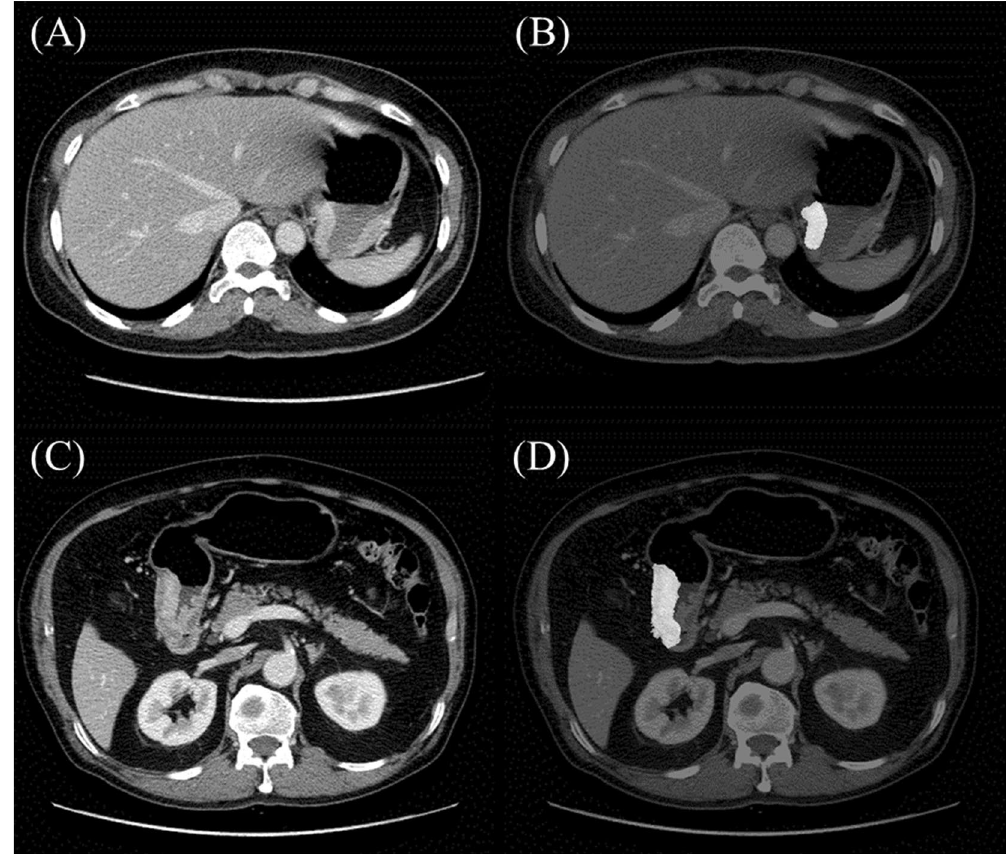
Figure 4. Patients with locally advanced gastric cancer whose recurrence risk was stratified into high and low risk by the radscore cutoff 1.16. ( A ) Computed tomography (CT) images on portal venous phase, ( B ) tumor segmentation in a 52-year-old woman with nodular extramural infiltration on CT whose radscore was 0.98, low risk group. Preoperative carcinoembryonic antigen (CEA) and carbohydrate antigen (CA) 19–9 was within the normal limit. Surgical pathology revealed tumor-node-metastasis (TNM) stage IIb with T4a and N0. There was no tumor recurrence during 96 months after surgery. ( C ) CT images on portal venous phase, ( D ) tumor segmentation in a 67-year-old man without nodular extramural infiltration on CT whose radscore was 1.66, high risk group. Preoperative CEA and CA 19–9 was within the normal limit. Surgical pathology revealed TNM stage IIIc with T4a and N3a. Liver metastasis occurred at 12 months after